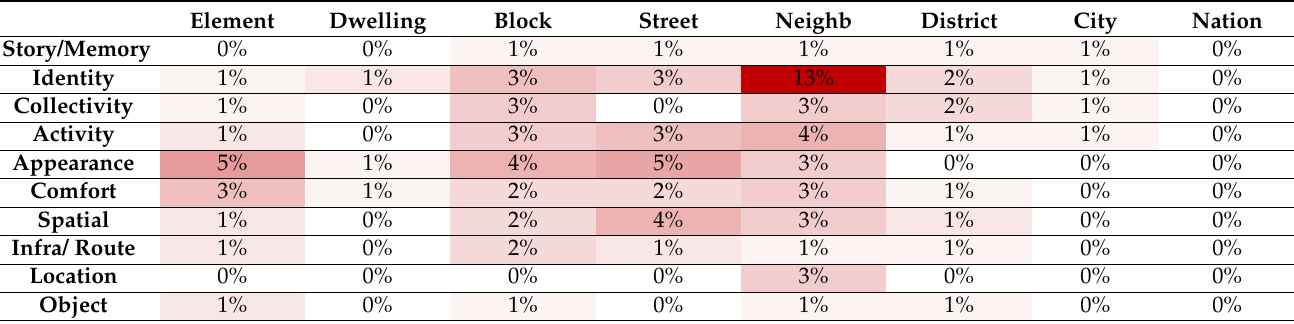
Table A8. Owners: five